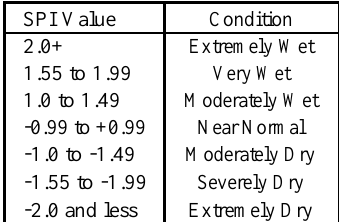
Table 1. SPI values and corresponding condition (McKee et al.,